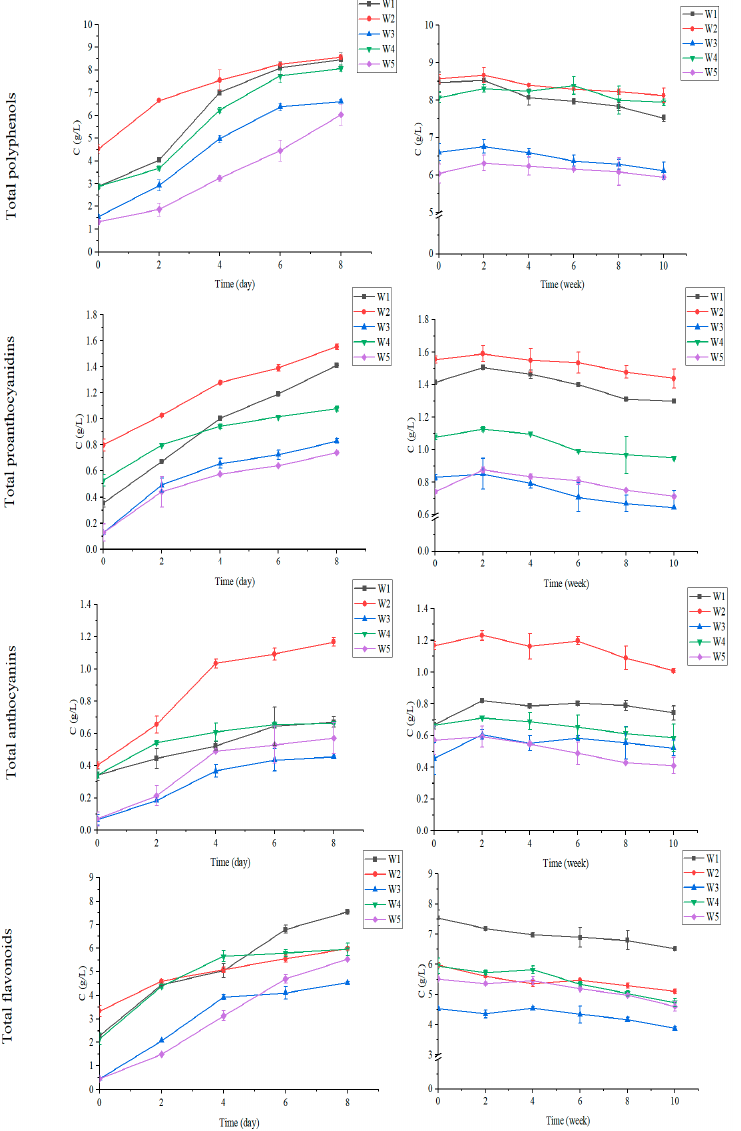
Figure 1. Total polyphenols, total proanthocyanidins, total anthocyanins and total flavonoids in black chokeberry wine. The left graph shows the alcoholic fermentation stage; the right graph shows the maturation stage. W1—wine made by traditional fermentation; W2—wine made by frozen fruit fermentation; W3—wine made by co-fermentation; W4—wine made by carbonic maceration; W5—wine made by co-carbonic maceration.